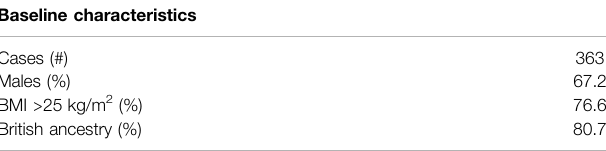
TABLE 3 | Baseline characteristics of HCM cases in